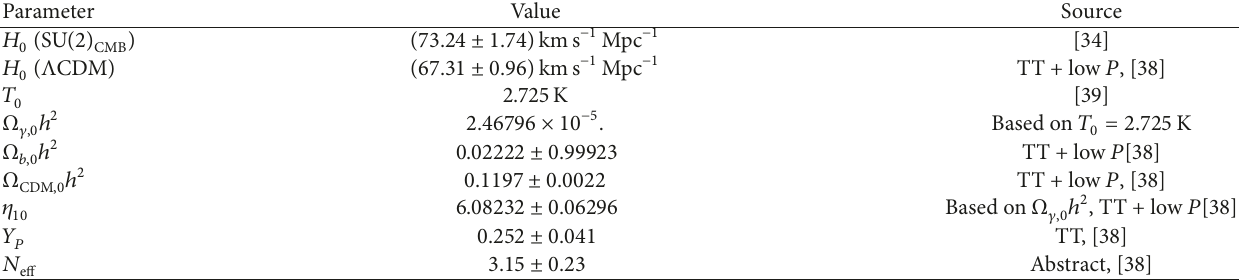
Table 1: Cosmological parameter values employed in the computations and their sources, taken from [28].